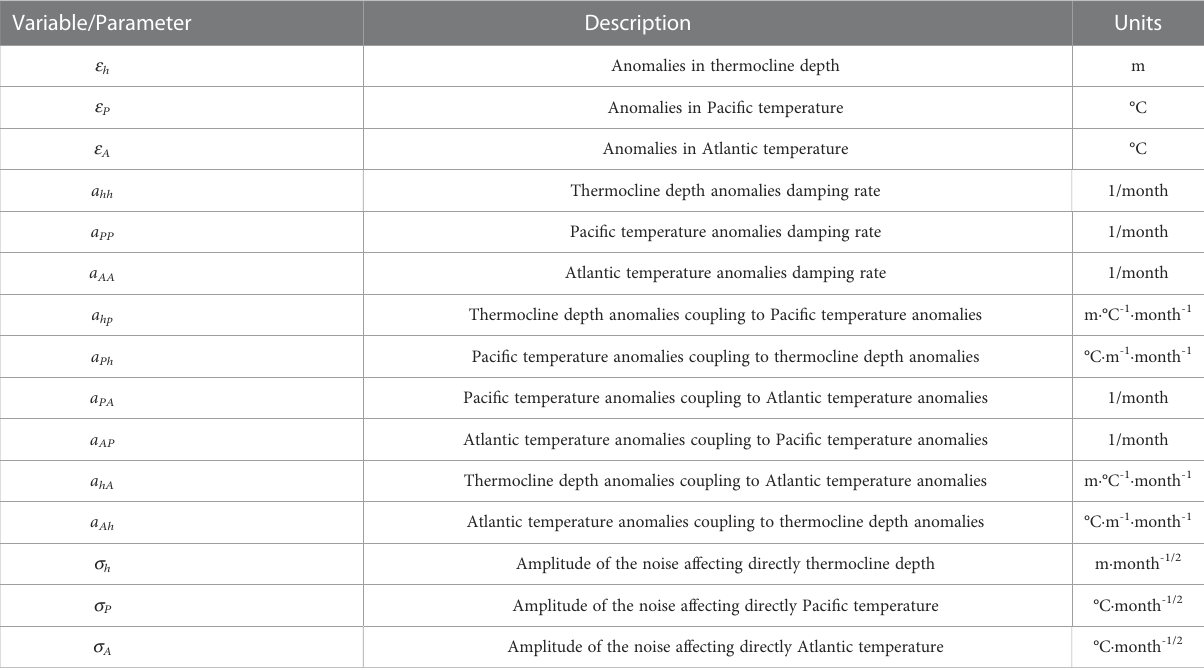
TABLE 1 Main variables and parameters used in this article, description and units.